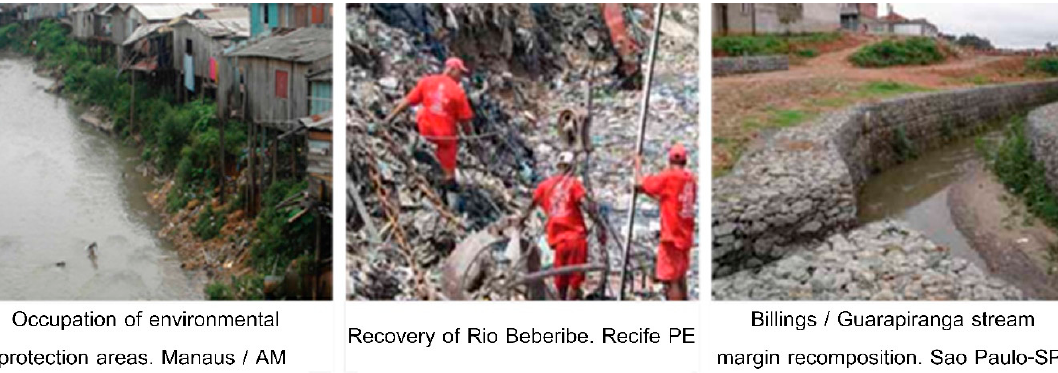
Figure 5. PAC: intervention areas [36].